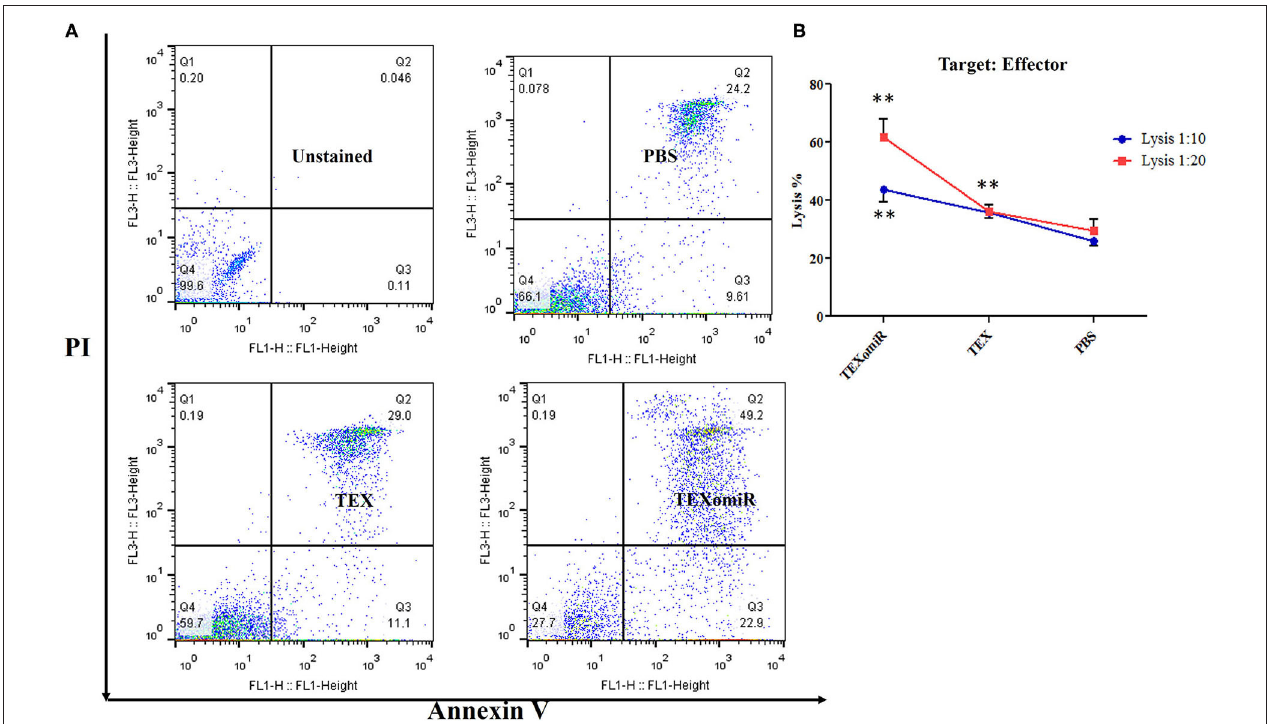
FIGURE 10 | Evaluation of the cytotoxic activity of splenocytes. (A) The TEXomiR group displayed a significant raise in cytotoxic activity against the target CT-26 cells compared with the TEX and phosphate-buffered saline (PBS) groups. (B) Lysis percentage in TEXomiR, TEX, and PBS groups at the ratio of 1:10 and 1:20. The data are presented as mean ± SD. ** P < 0.01. One-way ANOVA was used to make comparisons between groups. TEXomiR, miR-124-3p-enriched TEXs; TEX, tumor